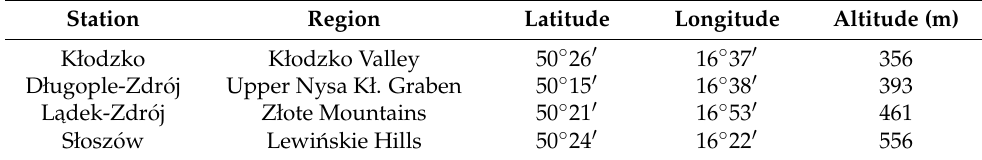
Figure 1. Location of meteorological stations and health resorts in Kłodzko Land. Table 1. Meteorological stations in the region of Kłodzko Land (with increasing alt itude).